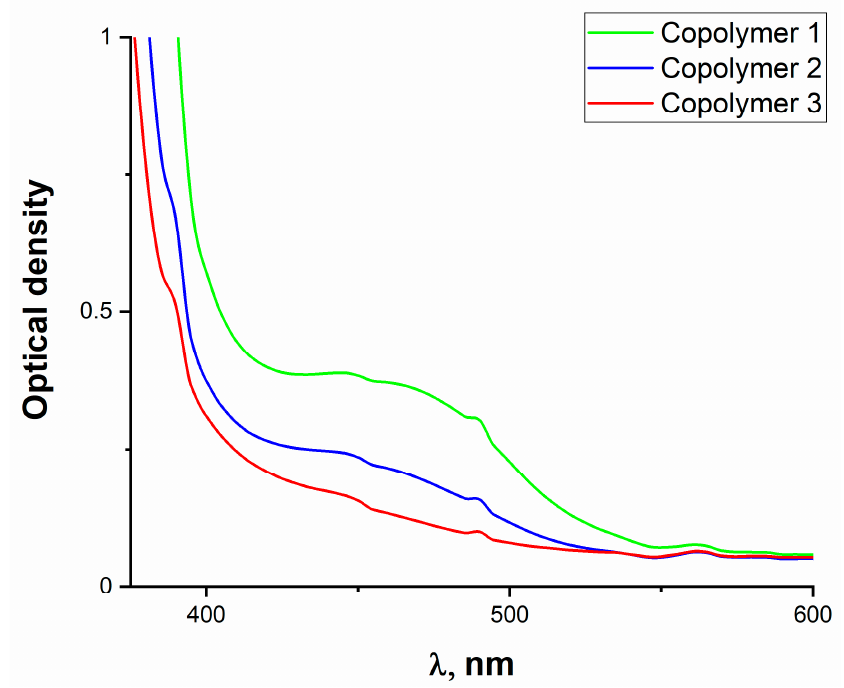
Figure 2. UV-visible spectra of copolymers with 1 wt.% CoAcr 2 PhTpy: copolymer 1—AAm/AAc 84.5/14.5; copolymer 2—AAm/AAc = 49.5/49.5; copolymer 3—AAm/AAc = 14.5/84.5.